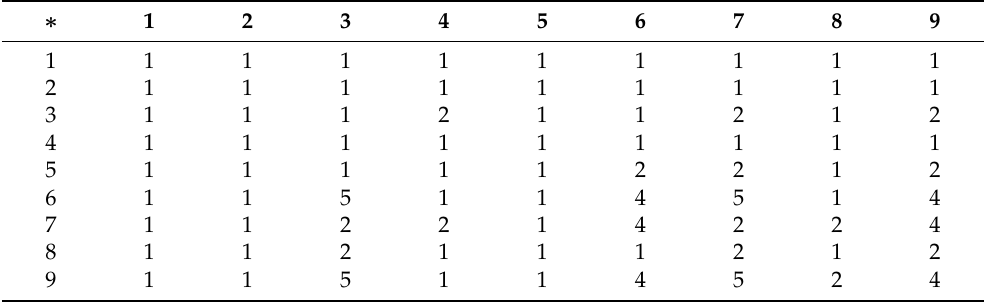
Table 1. A T2CA-groupoid of Example